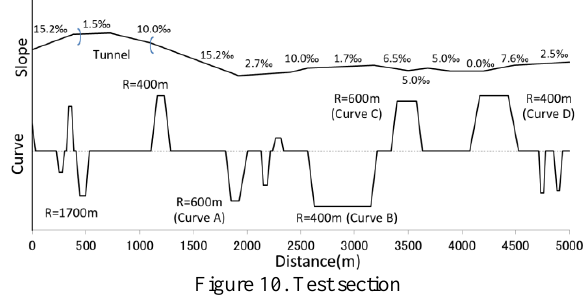
Figure 10. Test section